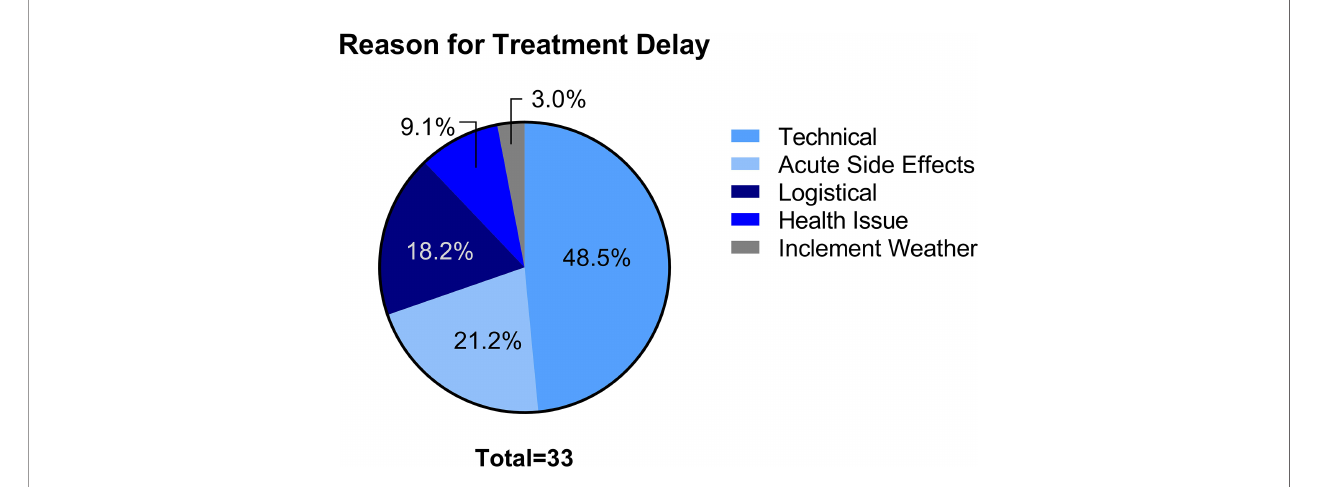
FIGURE 1 | Reason for treatment delay.